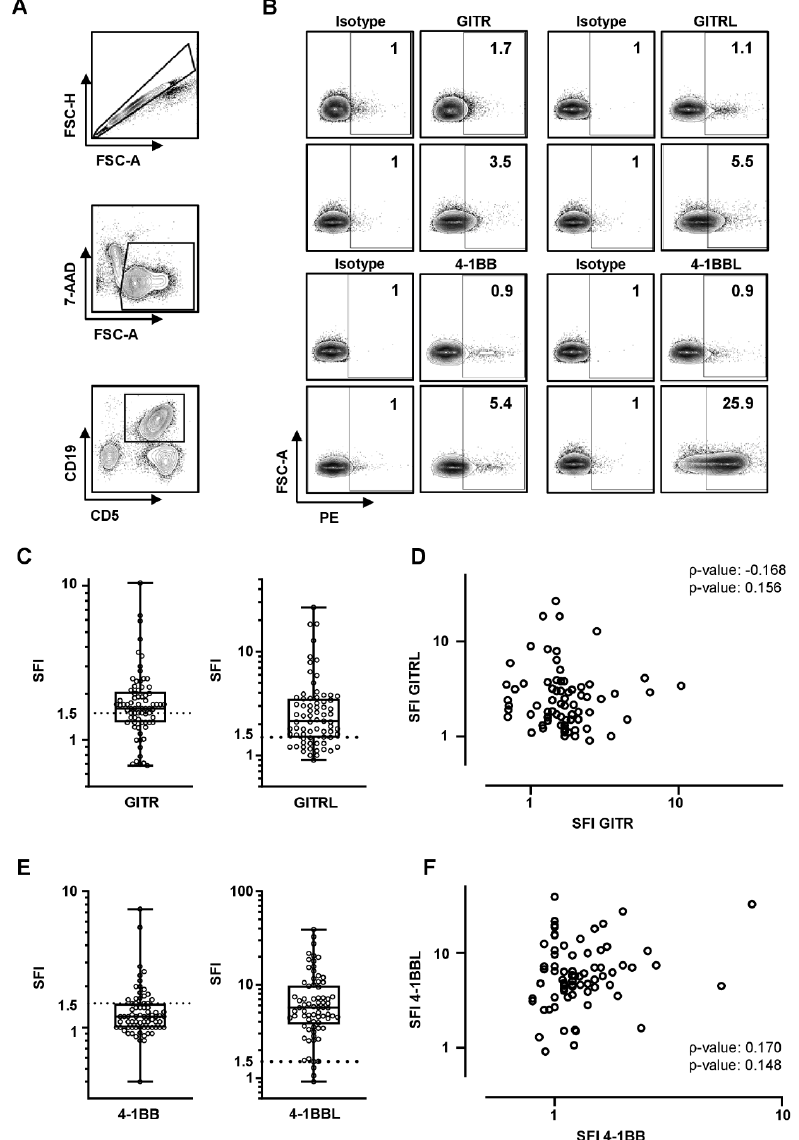
Figure 1. GITR/GITRL and 4-1BB/4-1BBL expression on chronic lymphocytic leukemia cells. GITR/GITRL/4-1BB/4-1BBL expression levels were analyzed on CLL cells by flow cytometry. ( A ) An exemplary gating strategy is depicted: singlets, viable (7-AAD-), CD5 + CD19 + CLL cells. ( B ) Gating strategy for low and high GITR/GITRL/4-1BB/4-1BBL expression levels of exemplary CLL samples compared to isotype is depicted. SFIs are shown on the right corner of each plot. ( C , E ) GITR/GITRL/4-1BB/4-1BBL expression levels on peripheral CLL cells ( n = 73) are shown as SFI levels of GITR, GITRL, 4-1BB, and 4-1BBL positive CLL samples (boxplots with min/ max whiskers). The SFI ≥1.5 is defined as positive and is depicted by dotted line. ( D , F ) Correlation of GITR and GITRL, and 4-1BB and 4-1BBL SFI levels on CLL cells is shown (single values, spearman correlation (ρ)).